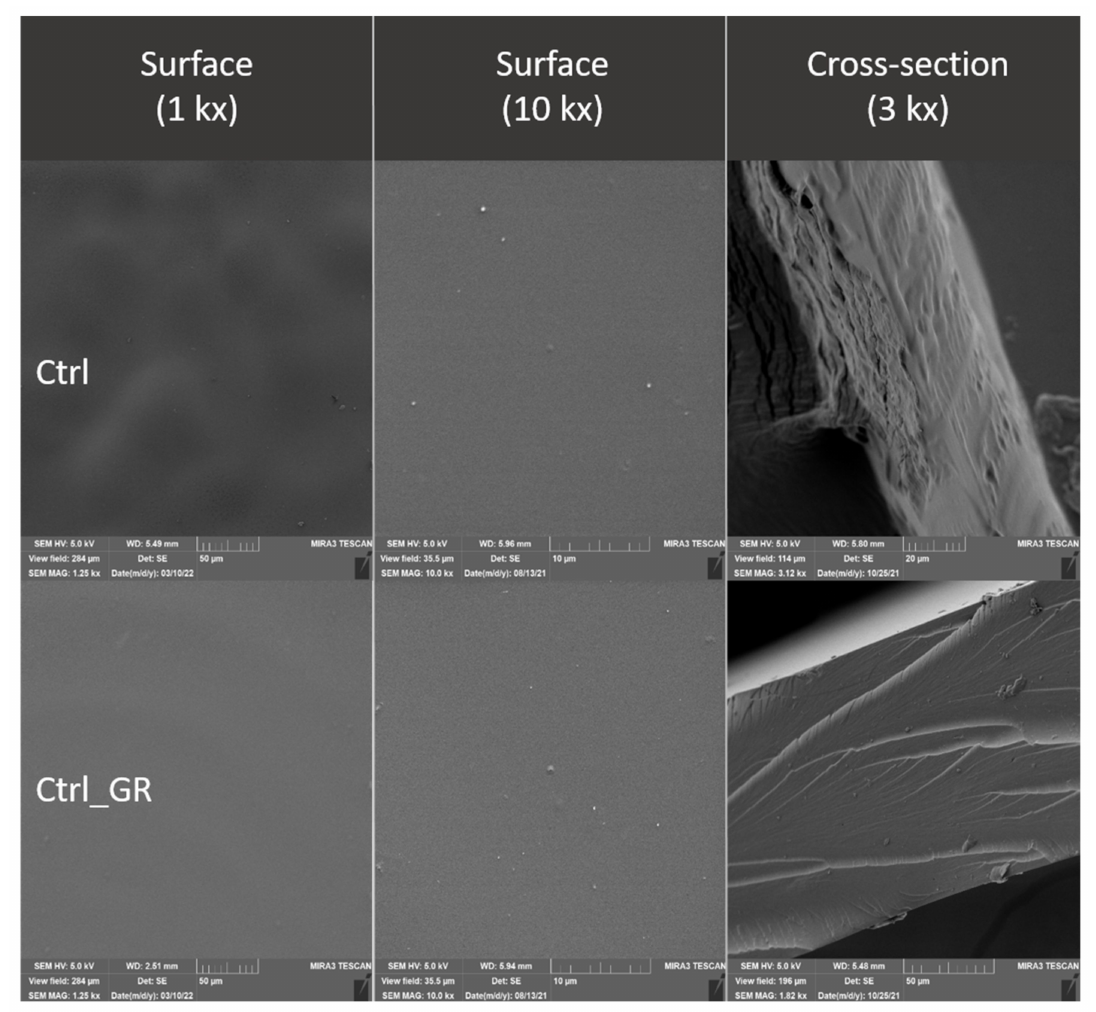
Figure 8. Surface and fracture microstructure of control samples of edible